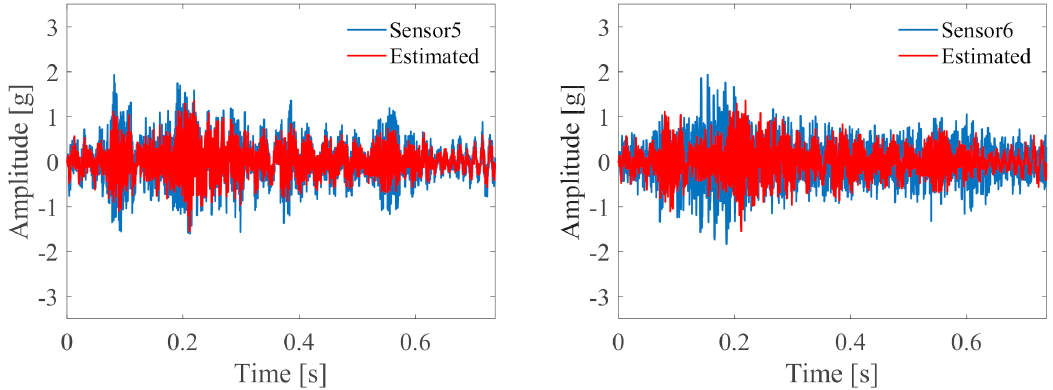
Figure 15. Contrasted results between estimated and real signals in inner race fault experiment.